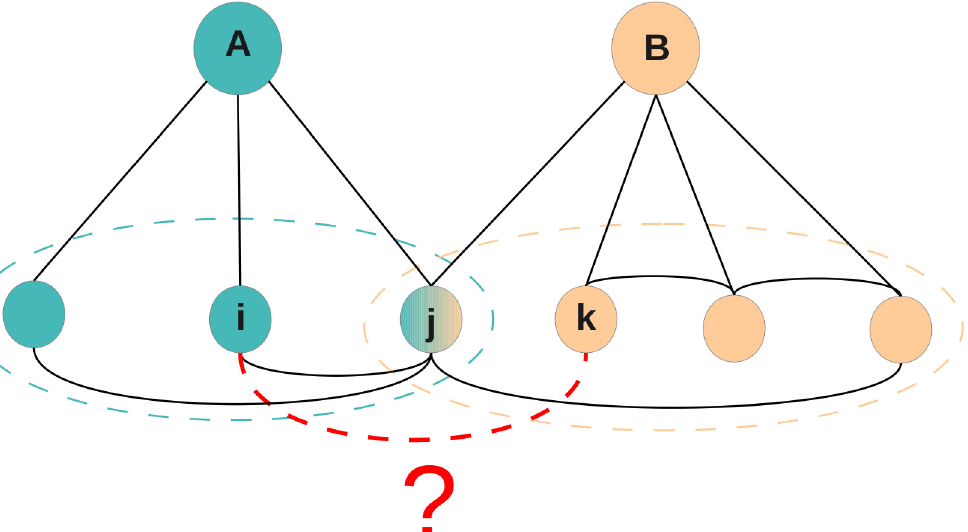
Fig 1. Facebook local networks. The local Facebook friendship networks provided by students A and B are shown in black. In particular, we know that i and j are friends on Facebook but not j and k , as i and j are both friends of A and j and k are both friends of B . On the other hand, we do not know if i and k are friends or not: the red dashed line represents the lack of knowledge about the potential existence of this relationship.